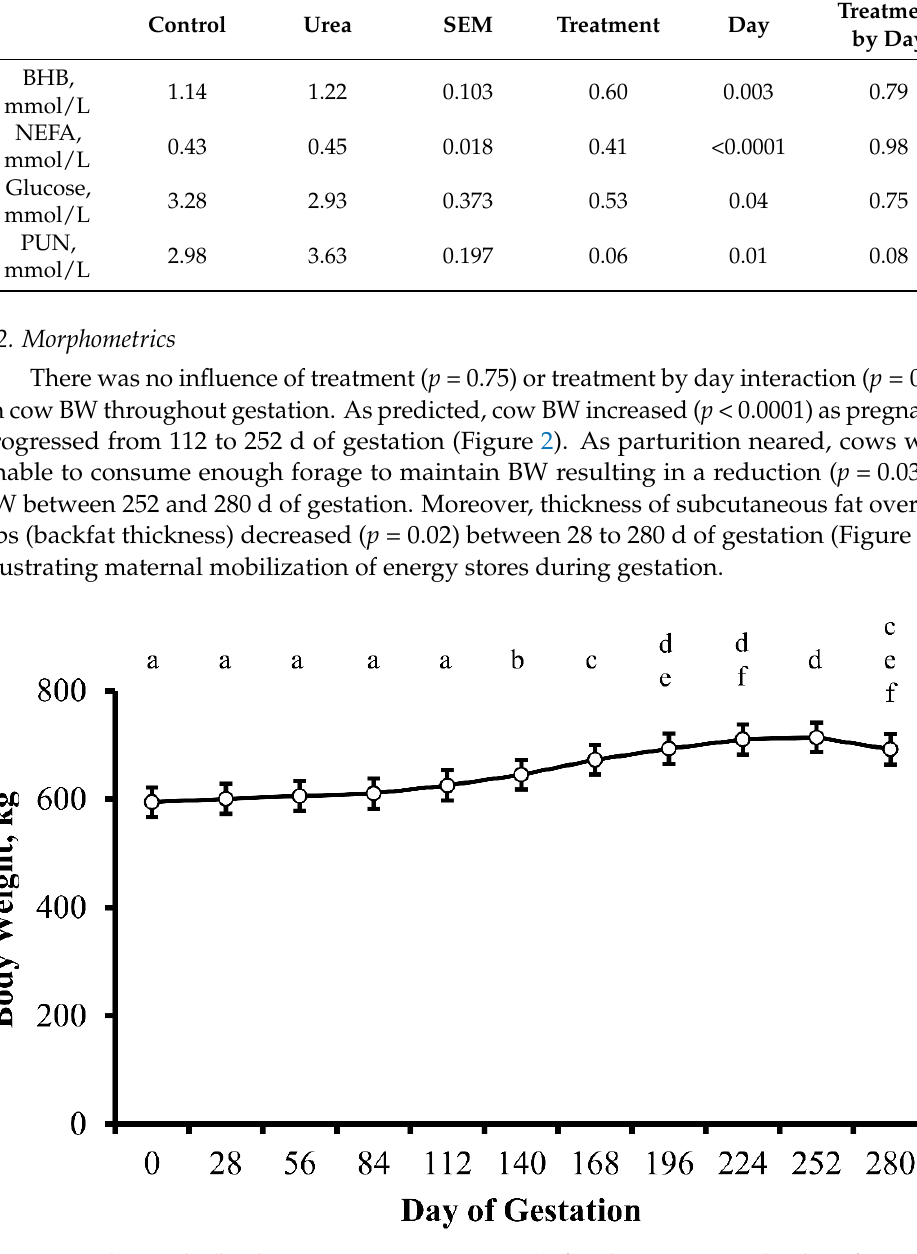
Table 2. Effect of dietary urea during gestation on beta-hydroxybutyrate (BHB), non-esterified fatty acids (NEFA), glucose, and plasma urea nitrogen (PUN) in multiparous cows. Dietary treatments were: Control (0 g urea/animal/day) or Urea (80 g urea/animal/day). Treatments were offered from day 28 of gestation to parturition.